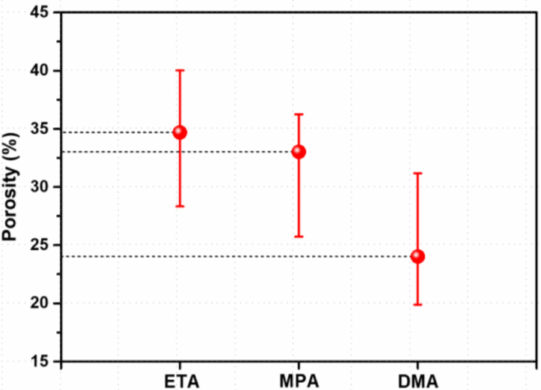
Figure 10. Porosity of the magnetite deposits on an Alloy 690TT tube depending on which of three advanced amines was used, as determined using an image analyzer.